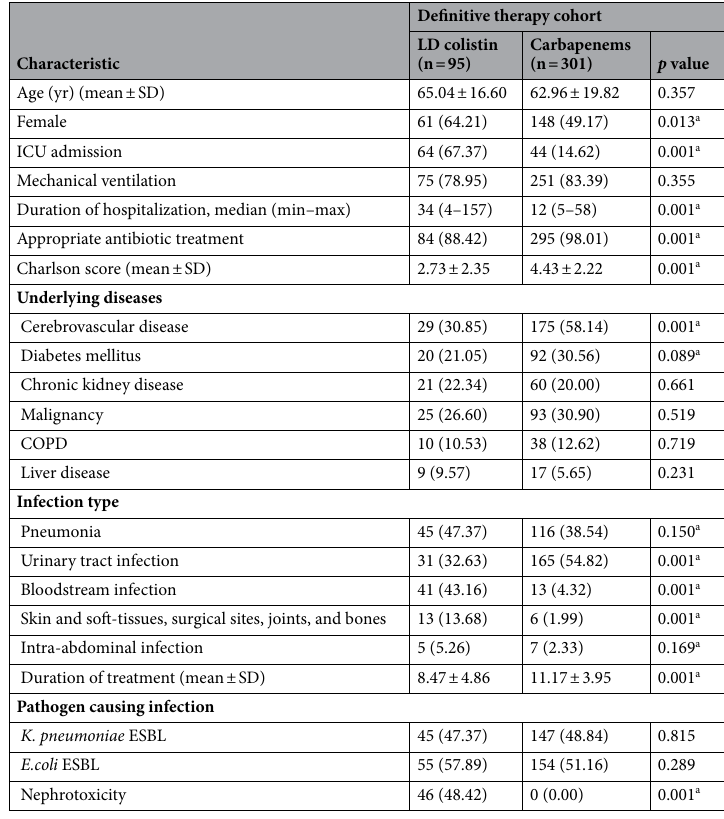
Table 1. Characteristics of patient infection caused by ESBL-producing E. coli and K. pneumoniae. a Variable used to adjustment for treatment with LD